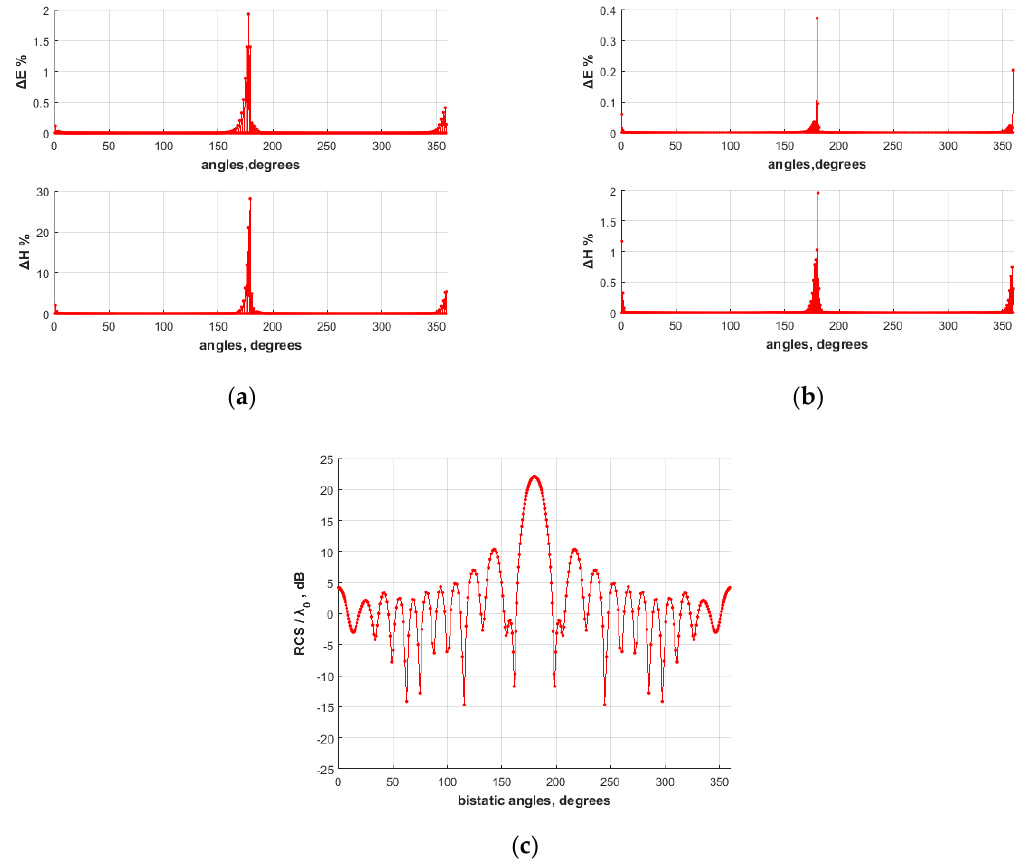
Figure 7. Results for lossless dielectric scatterer: ( a ) E and H field boundary the condition error by employing a conformal auxiliary surface; ( b ) E and H field boundary the condition error by employing a deformed auxiliary surface; ( c ) the Radar Cross Section (RCS) acquired by utilizing the auxiliary surface deformation scheme.